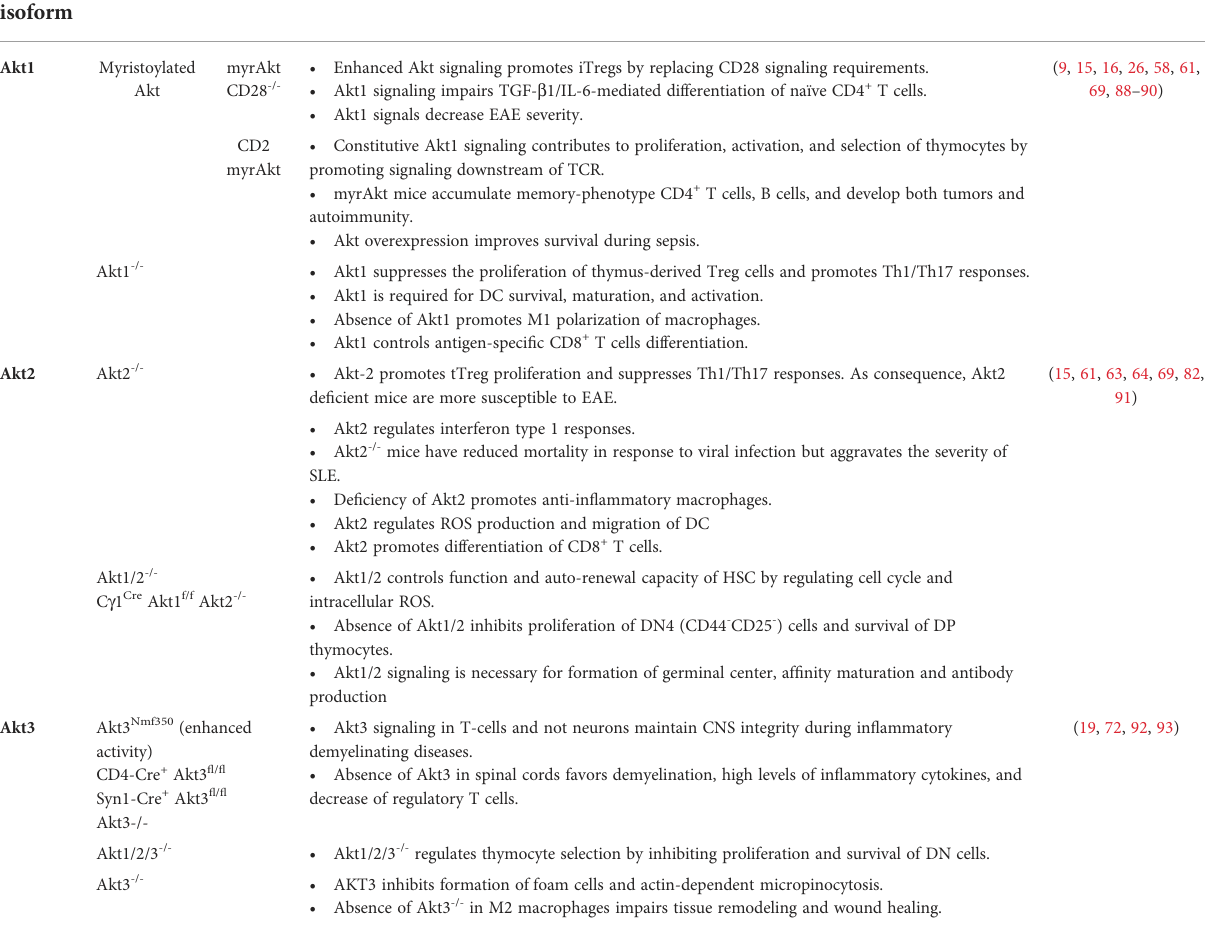
TABLE 1 Akt isoform animal models provide insights into their immunological roles. Akt